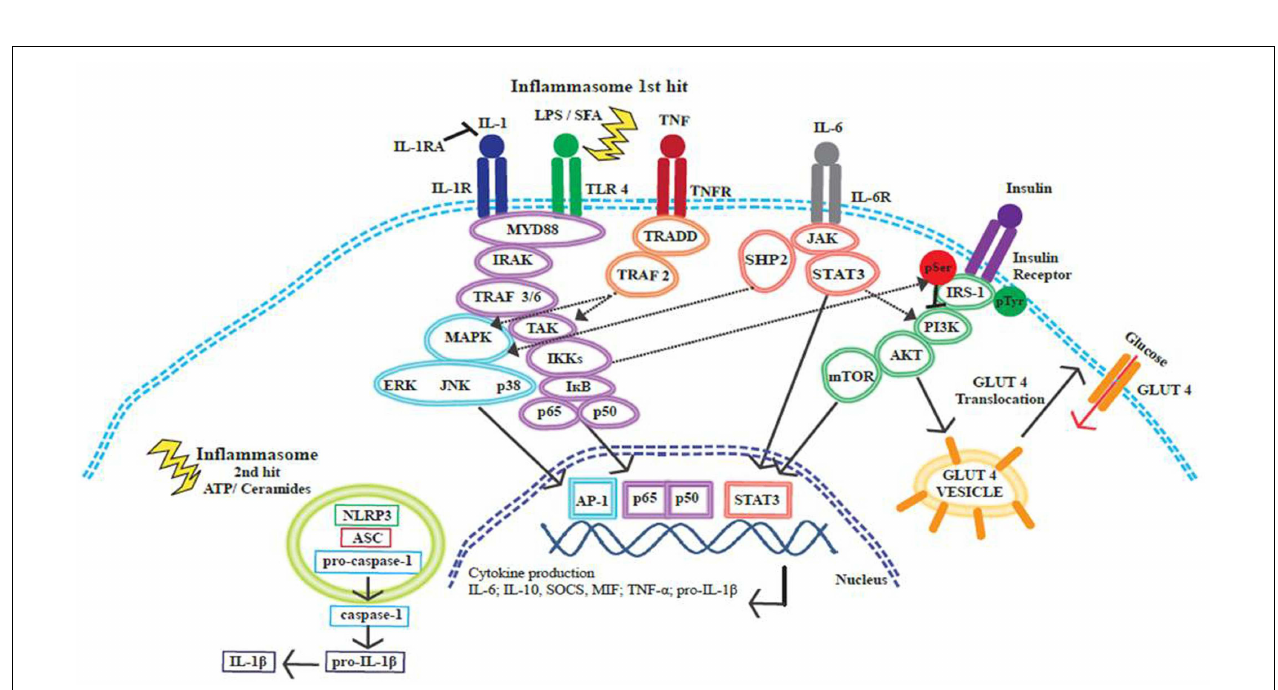
hit.The NLRP3 inflammasome acts on pro-caspase-1 causing the release of caspase-1; caspase-1 then acts upon pro-IL-1 β cleaving this precursor to the active IL-1 β form. Insulin signaling promotes glucose uptake by promoting the translocation of GLUT4 to the cell surface plasma membrane. Inflammatory signaling pathways can alter the phosphorylation status of IRS-1. IRS-1 is crucial in the insulin signaling pathway, tyrosine phosphorylation is associated with an insulin sensitive state. IKK β and JNK can promote serine phosphorylation of IRS-1 and this phosphorylation state is linked to insulin resistance and reduced glucose